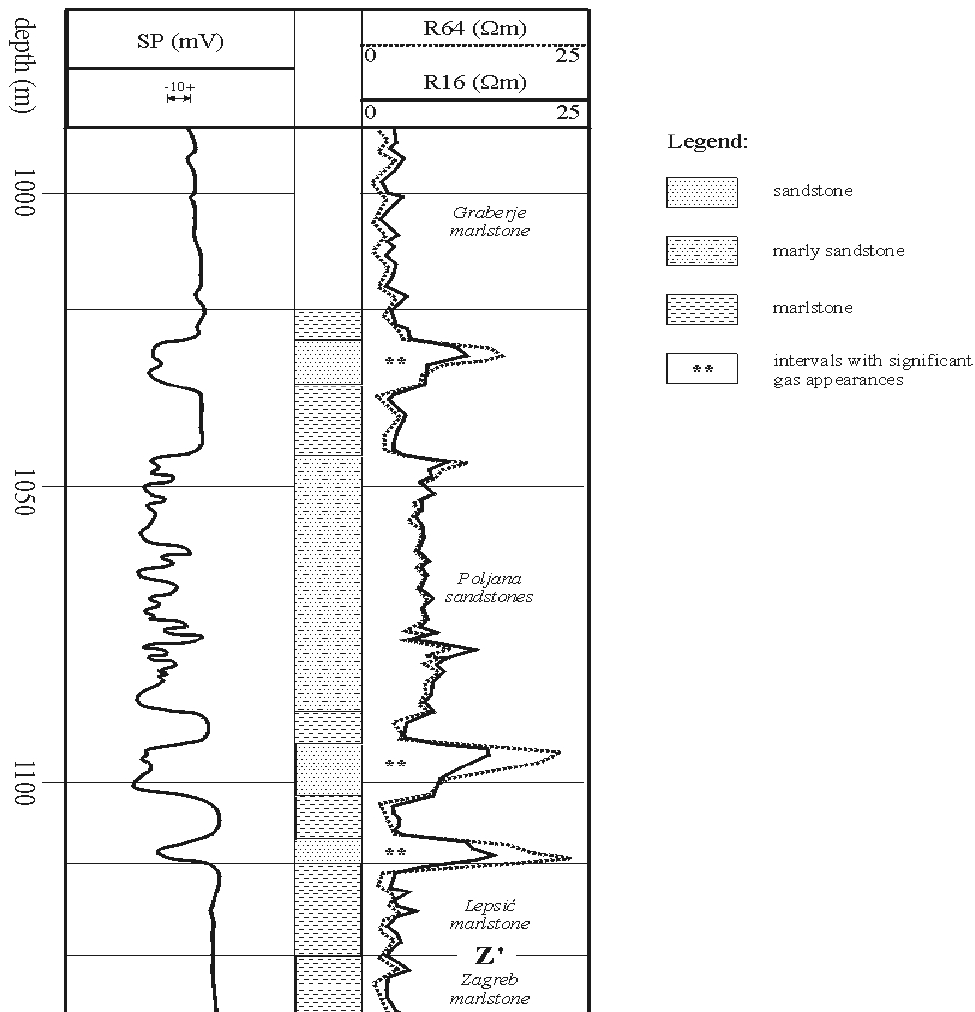
Figure 6. Sudden changes between medium-grained and marly sandstone layers inside a single lithostratigraphic member showed qualitatively on SP/R e-logs.